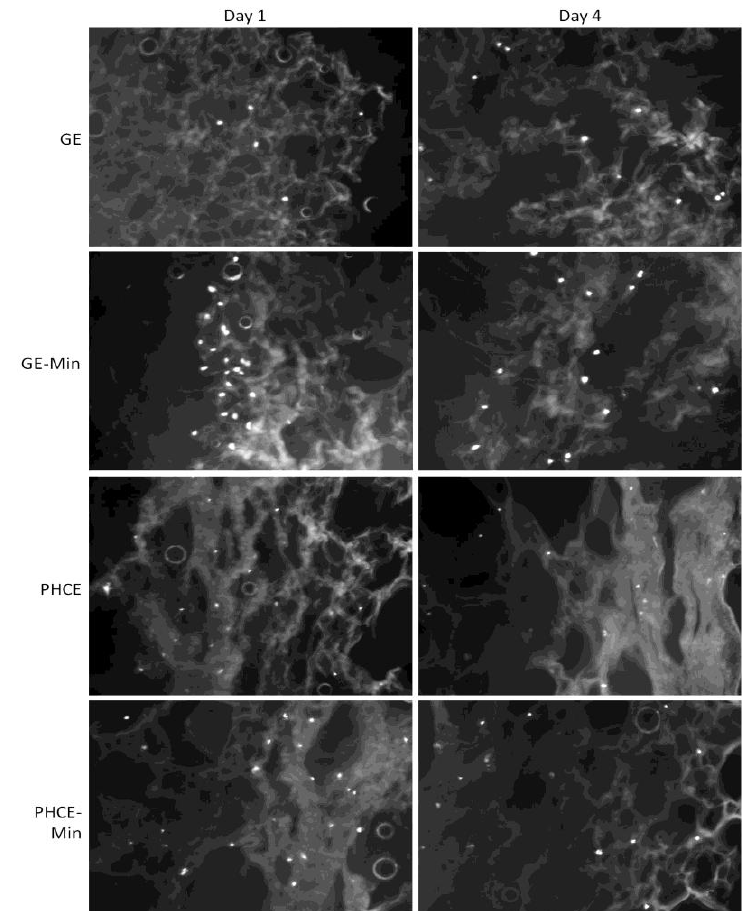
Figure 12. 4′-6-diamidino-2-phenylindole (DAPI) staining of mineralized and non-mineralized GE and PHCE scaffolds after dynamic cell seeding and subsequent static culture for 1 and 4 days. Increases in cell attachment (GE-M) and attachment/infiltration (PHCE and PHCE-M) are observed. All images taken at 10×